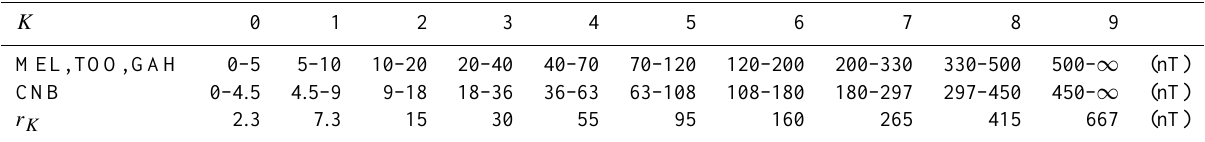
Table 2. Scale values used to convert magnetogram ranges to K values, and scaling factors r K used to estimate a -index values from K . K 0 1 2 3 MEL, TOO, GAH